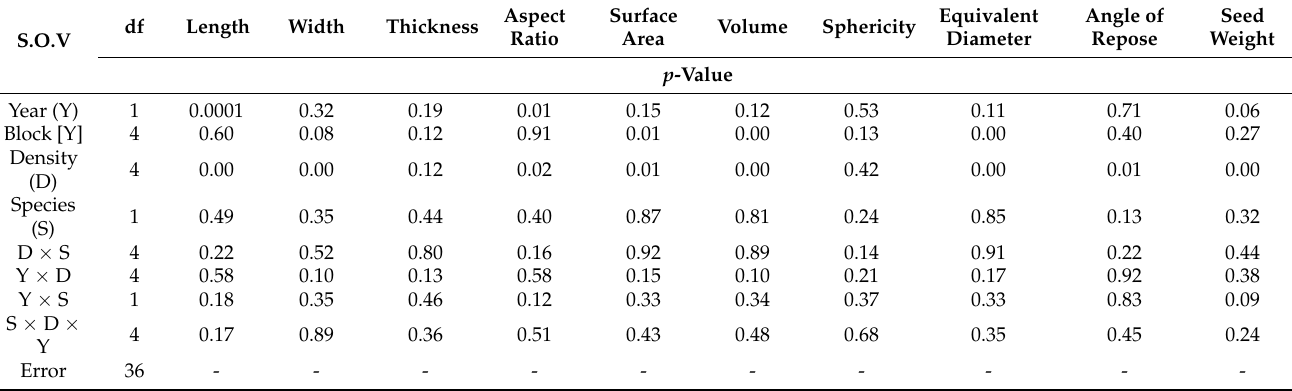
Table 1. Analyses of variance of the effects of weed species (S), weed density (D) and their interaction on maize seed properties obtained in two-field experiment conducted in 2006 and 2007. S.O.V